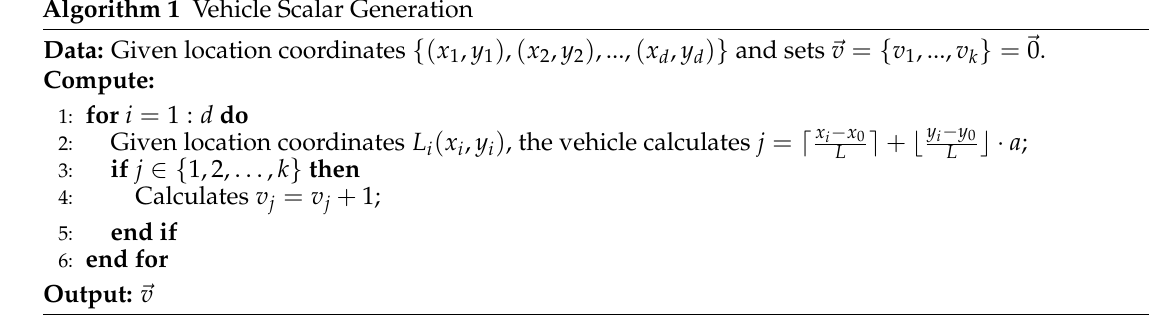
Algorithm 1 Vehicle Scalar